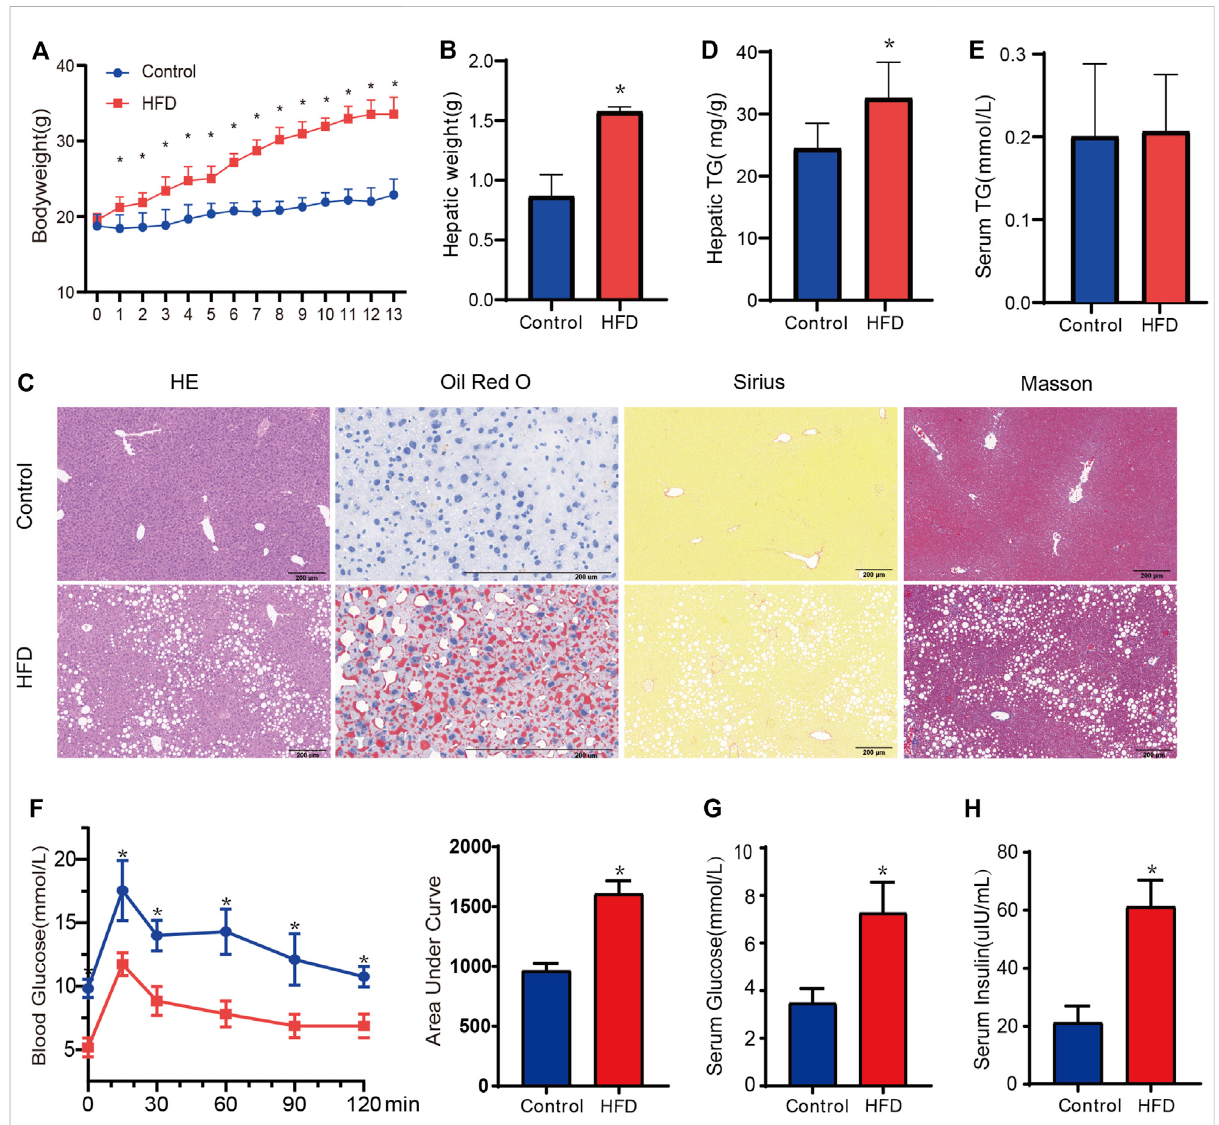
FIGURE 7 Evaluation of metabolic phenotypein the HFD-fed mice. (A,B) The body weight and hepatic weight between HFD and CD groups, respectively. n = 6. (C) Representative HE staining, Oil-red O staining, Masson staining, and Sirius red staining images of liver from each group. Black scale bar, 200 um. (D,E) The hepatic TG and serum TG between HFD and CD group. n = 5. (F) The oral glucose intolerance test (oral administration of 1.0 g/kg of glucose, after 12 h fasting). (G,H) Fasting serum glucose and insulin were measured. n = 5. Data are mean ± SD. * p < 0.05 versus CD